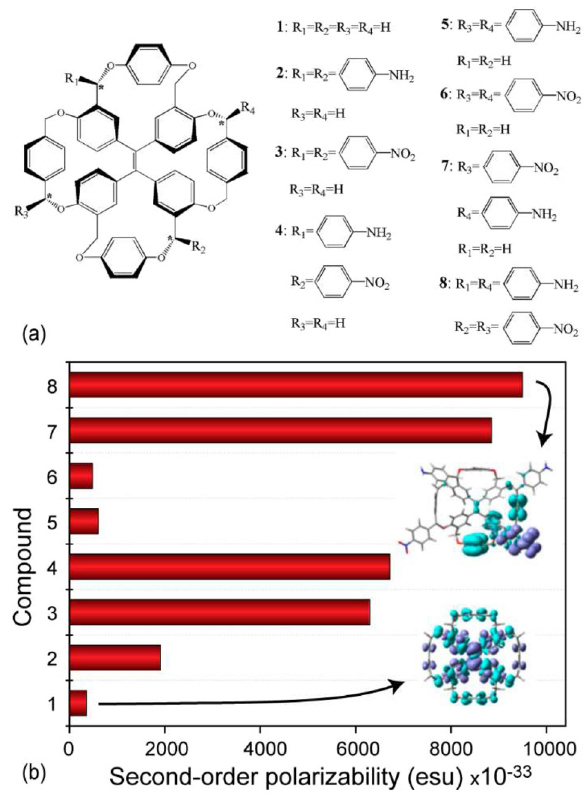
Figure 6: (a) Structures of a series of cyclic TPEs. (b) Second-order polarizabilities of the synthesized TPE derivatives in part (a). The second order polarizability increased approximately 27 times from 1.50 × 10 − 34 m/V to 3.98 × 10 − 33 m/V (converted from esu units) by changing the residues. Inset: DFT modeling of compounds 1 and